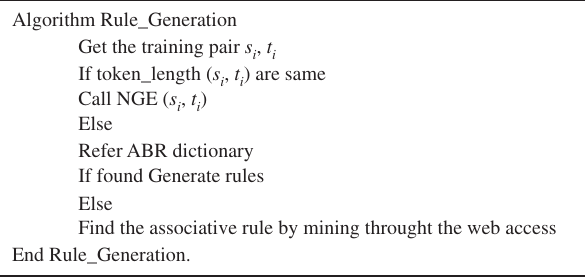
Figure 3: Rule Generation Algorithm.